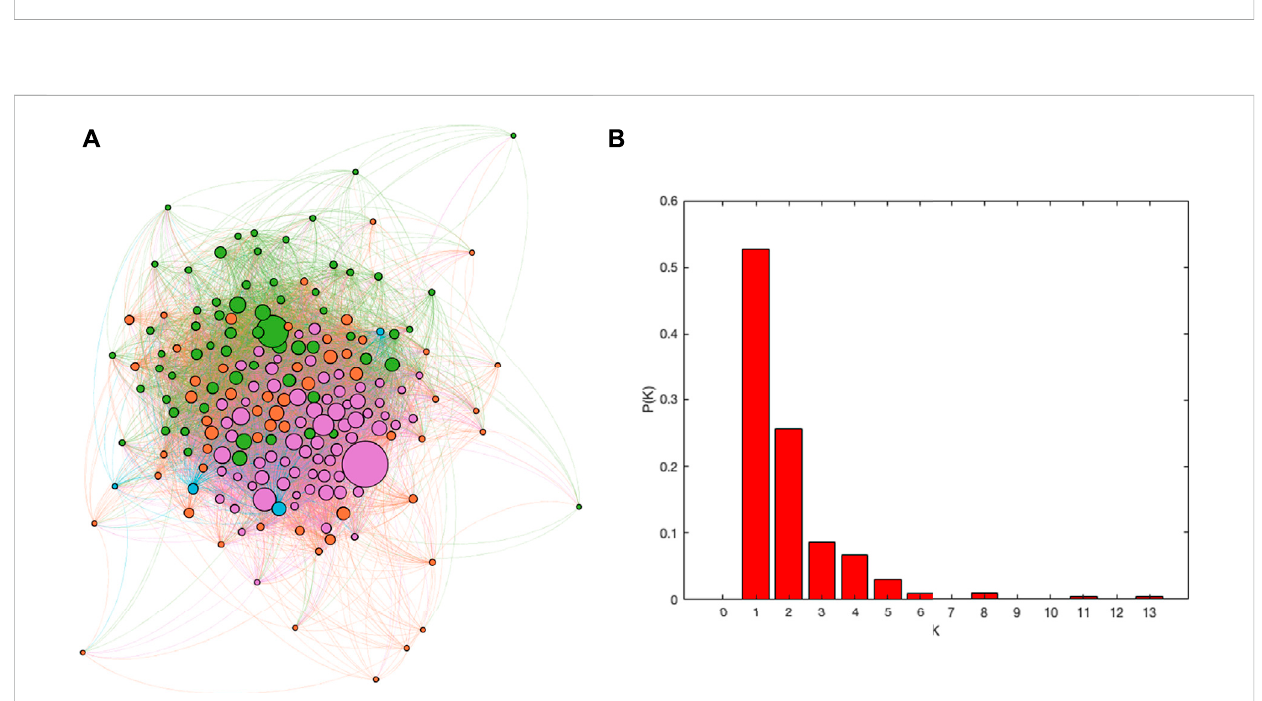
FIGURE 2 (A) 2011Q1 fund network visualization. (B) 2011Q1 fund node degree distribution. In (A) , the size of a node is proportional to its degree. Each color represents a community, detected by the Louvain algorithm. The color of an edge is aligned with the color of the node with a larger common holding